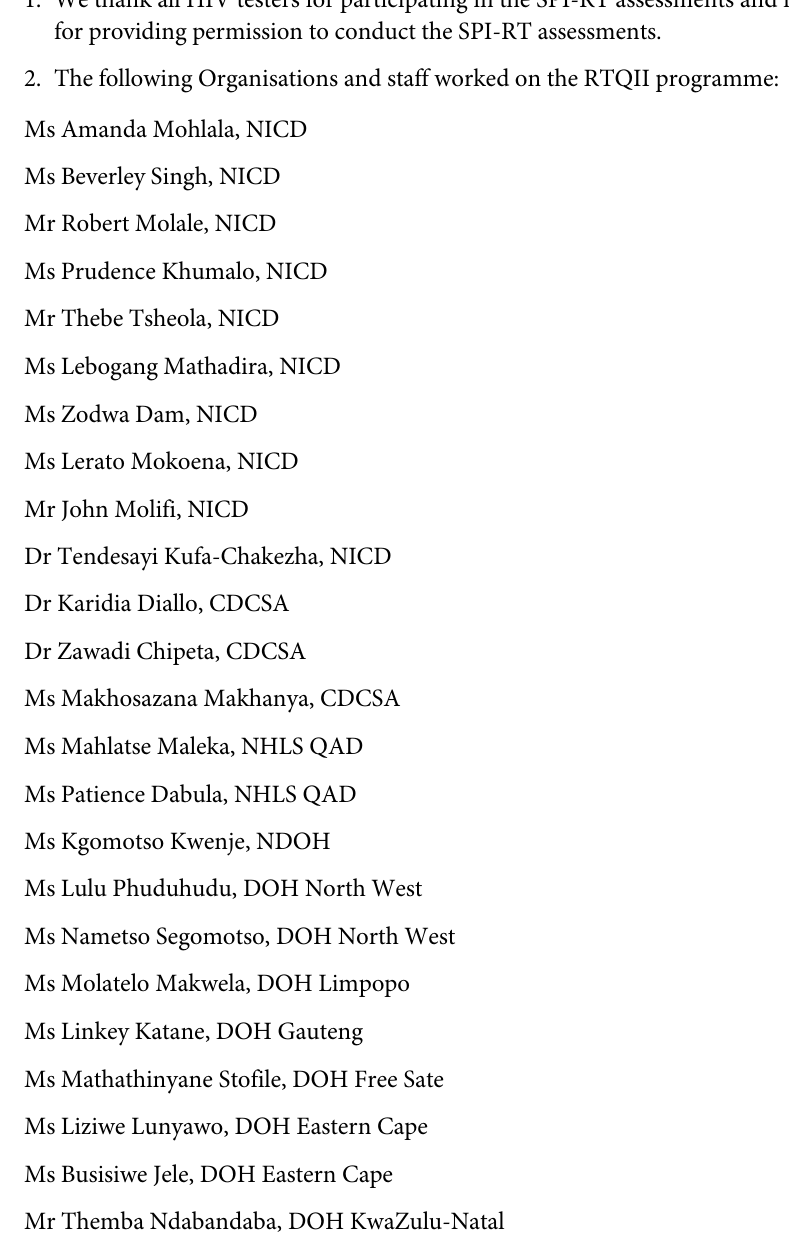
S2 Fig. Proportion of facilities trained by year of training and province, South Africa. (DOCX) S3 Fig. Percentage of HIV testing facilities with increased performance levels in round- two, South